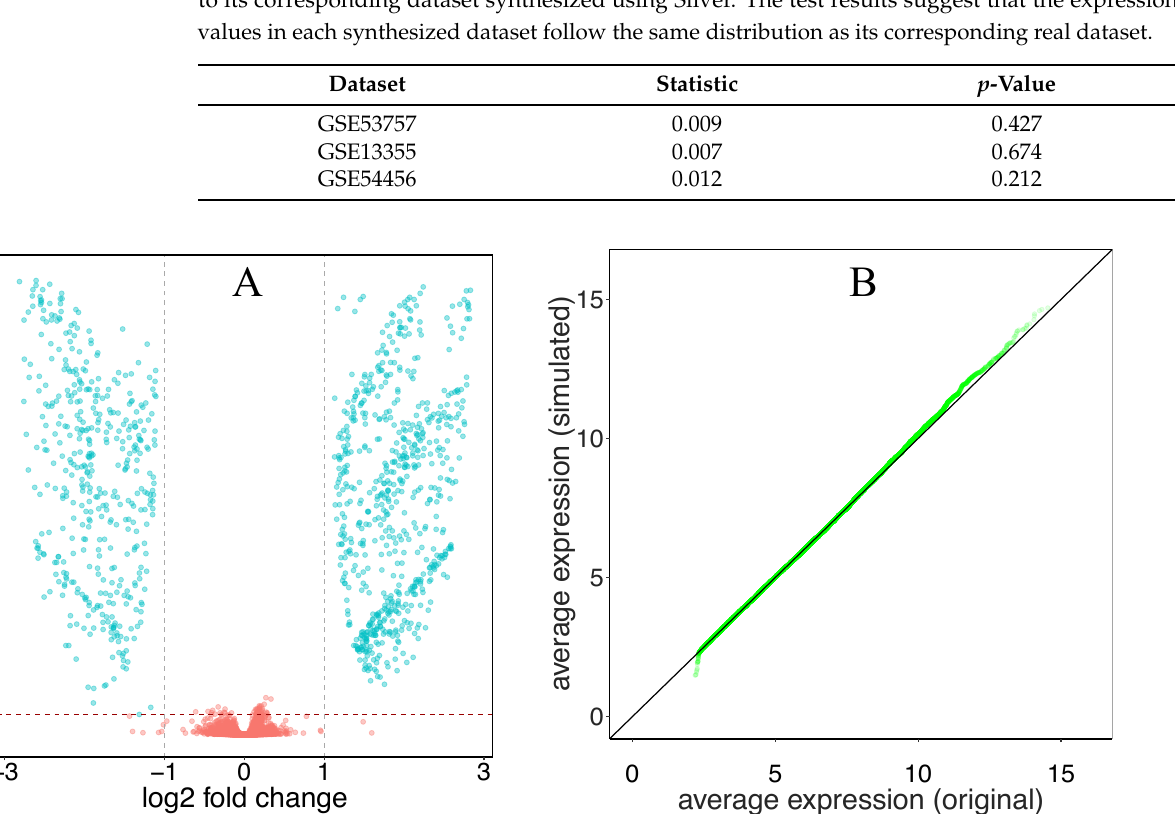
Figure 3. ( A ) The volcano plot shows differentially expressed genes resulting from simulated data (20 control and 20 case samples) using dataset GSE53757. The blue points represent genes that were differentially expressed and the red points represent non-differentially expressed genes. The vertical dotted lines indicate the log fold change thresholds that were considered significant. The red horizontal line indicates the p -value cutoff, 0.05. The p -values were obtained by performing differential expression analysis using the limma R package. ( B ) A Q–Q plot of the average expression values of cases versus controls for the synthesized dataset generated from